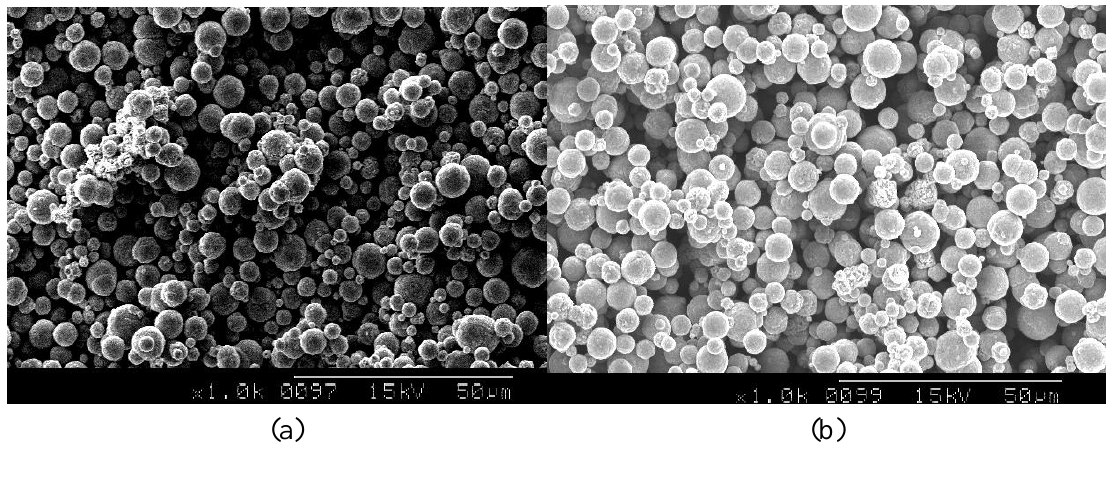
Figure 2. SEM photomicrographs of Ni powder (3–7  m), as received ( a ), and etched for 5 minutes ( b